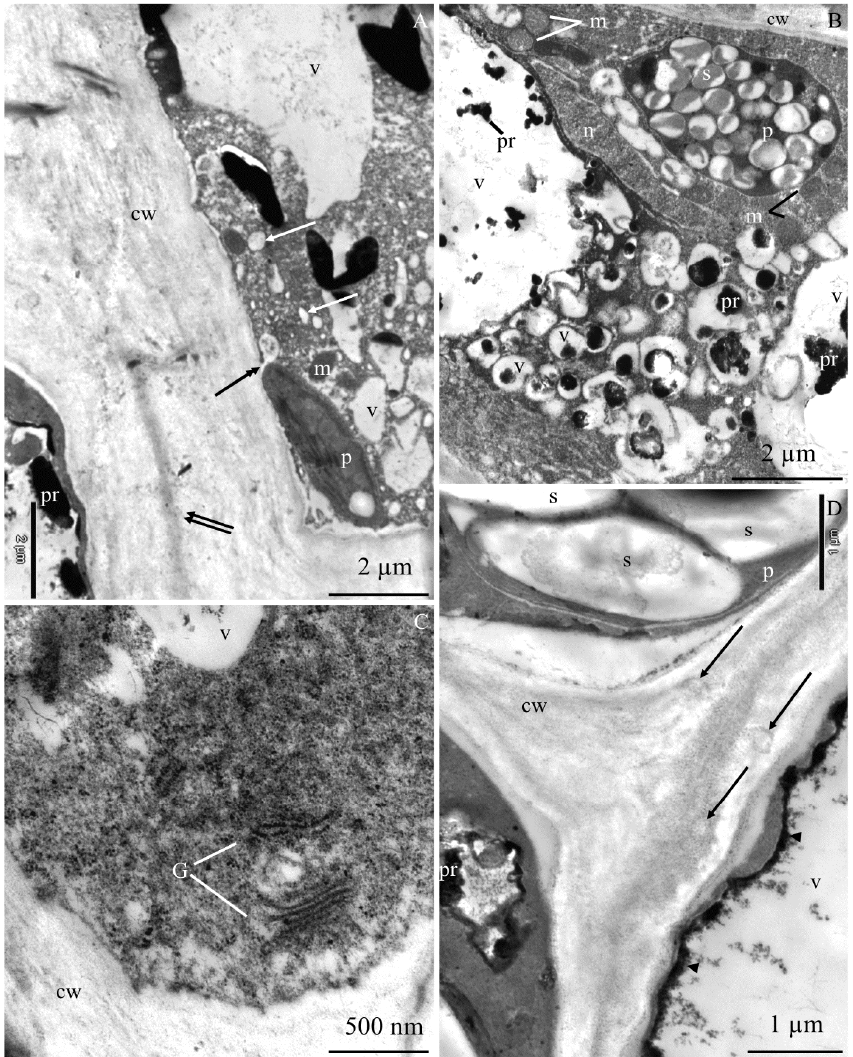
Figure 5. Fragments of the cross sections of hypodermis cells from the apical part of ‘Szampion’ apples from the CaCl 2 foliar feeding treatments. A : cell wall (cw), visible middle lamella (two arrows), parietal cytoplasm with numerous transport vesicles (arrow), plasmalemma invaginations (double-headed arrow), plastid (p) with a starch grain (s). B : protoplast, visible lobular cell nucleus (n), large vacuole (v) and numerous small vacuoles, precipitates (pr) in cell sap. C : cell wall (cw), electron dense cytoplasm, Golgi apparatus (G), vacuole (v). D : cell wall (cw), visible vesicles (arrow), plastid (p) with starch grains (s), tonoplast (arrowhead), flocculent substance collected at the tonoplast and in cell sap.